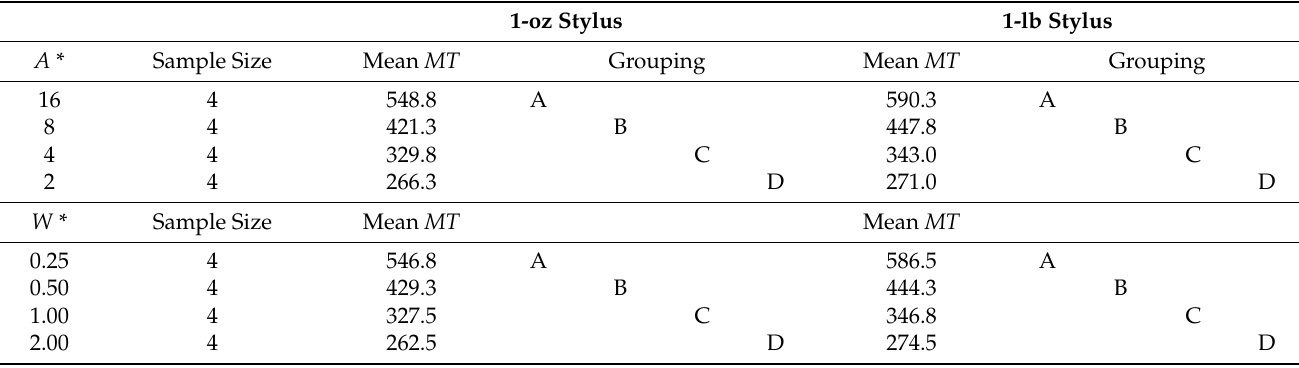
Table 8. Tukey simultaneous tests for the effects of amplitude and target width effect on MT in 1 oz and 1 lb stylus tapping from Fitts’ data [1] had results consistent with those in this